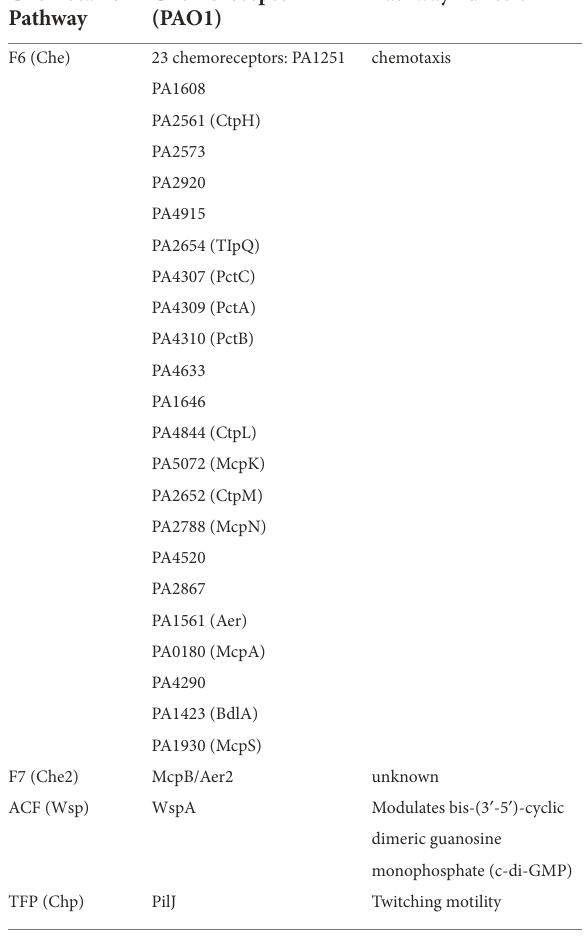
TABLE 2 Pseudomonas aeruginosa chemotaxis pathways, pathway receptors, and pathway functions (Matilla et al.,